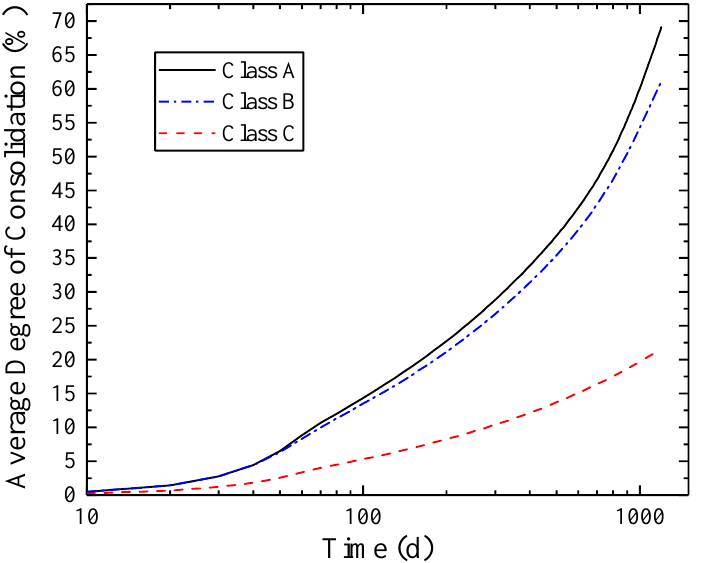
Figure 13. Comparisons of average degree of consolidation.